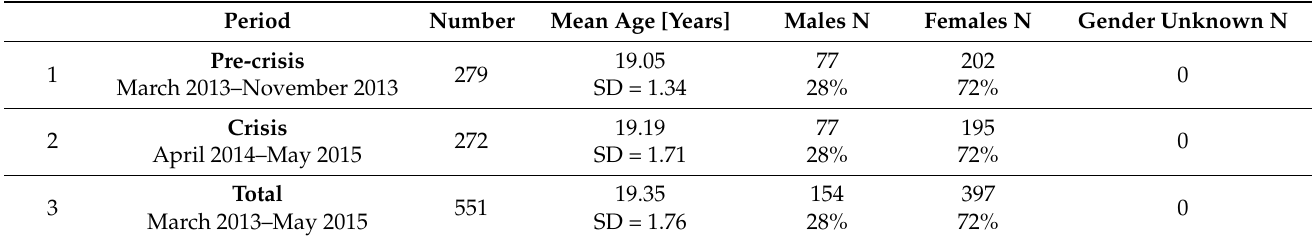
Table 2. Characteristics of the south-eastern region sample based on age, sex, and time of data